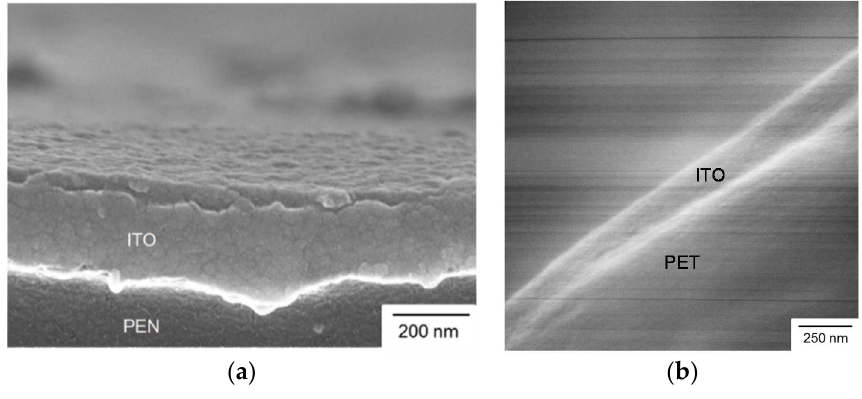
Figure 13. Cross-sectional SEM micrographs of ( a ) ITO/PEN sheet and ( b ) ITO/PET sheet.